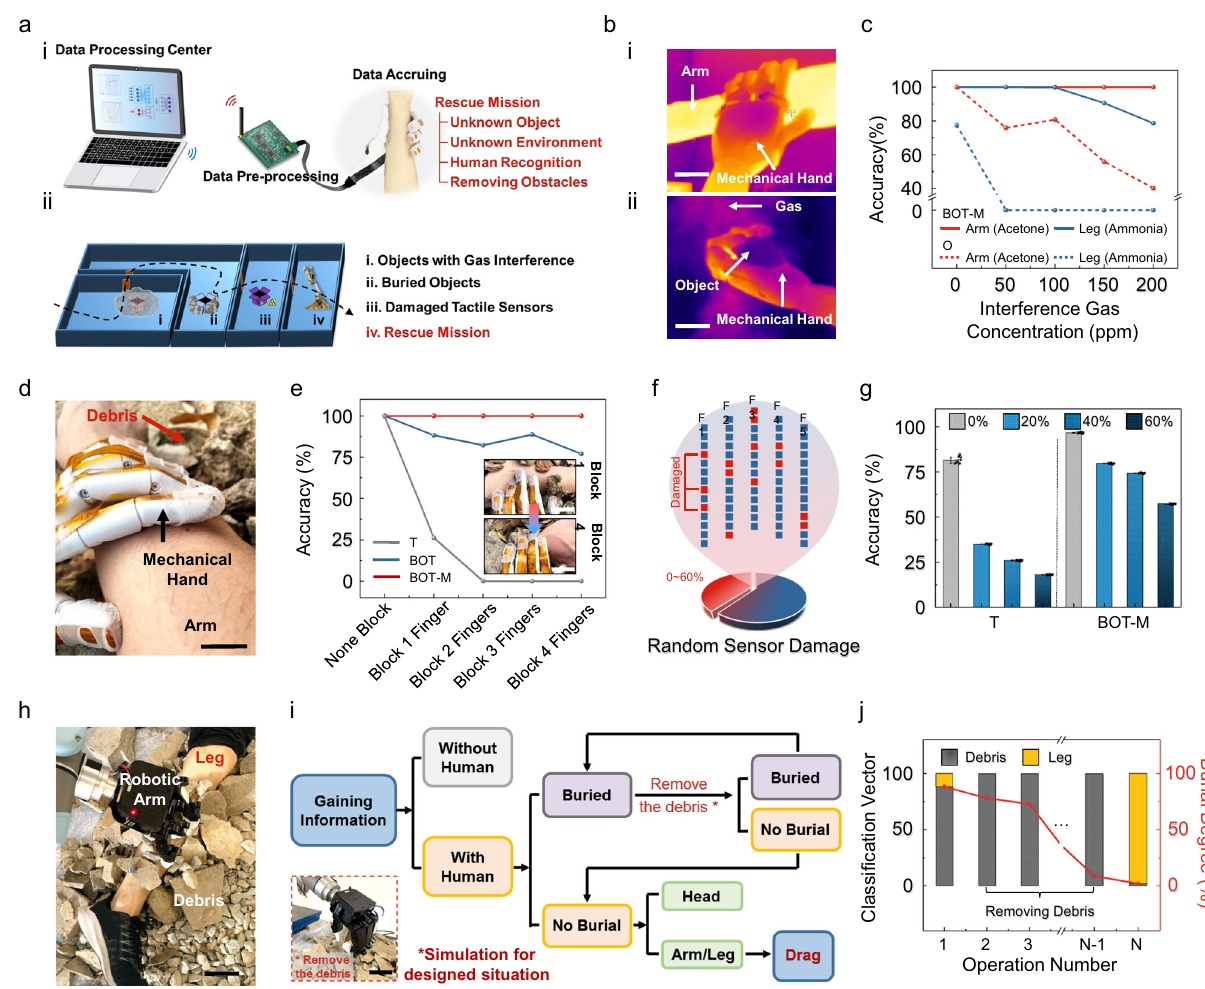
Fig. 4 Human recognition in a hazardous environment based on BOT. a Schematic illustration of the testing system and scenarios. (i) Scheme showing the system consisting of a computer, a wireless data transmission module, a data pre-processing circuit board, and a mechanical hand. (ii) Four different hazardous application scenarios including gas interference, buried objects, partially damaged tactile sensors, and simulated rescue mission. b IR photographs of the mechanical hand holding different objects (i. an arm and ii. other objects) with various gas interference, scale bar: 4 cm. c Recognition accuracy for different parts of the human body under the interference of various gas concentrations (50, 100, 150, and 200 ppm) of acetone and ammonia using olfactory-based recognition and BOT-M associated learning. d Photograph of arm recognition underneath the debris, scale bar: 1.5 cm. e The change of arm recognition accuracy as burial level continues to increase using tactile-based recognition, BOT, and BOT-M associated learning. Inset: Photos of one fi nger (Top) and four fi ngers (Bottom) of the mechanical hand being blocked from touching the arm, scale bar: 5 cm. f Scheme showing damage to random parts of both force and gas sensors in the tactile array. g The accuracy for arm recognition with different sensor damage rates using tactile-based recognition and BOT-M associated learning. n = 10 for each group. The error bars denote standard deviations of the mean. h Photograph of a volunteer ’ s leg buried underneath debris and a robotic arm performing the rescue mission, scale bar: 8 cm. i Flow diagram shows the decision-making strategy for human recognition and rescue. Inset: Photograph of the robotic arm removing the debris, scale bar: 10 cm. j The variation of leg/debris classi fi cation vector and the alleviated burial degree while the covering debris being gradationally removed by the robotic